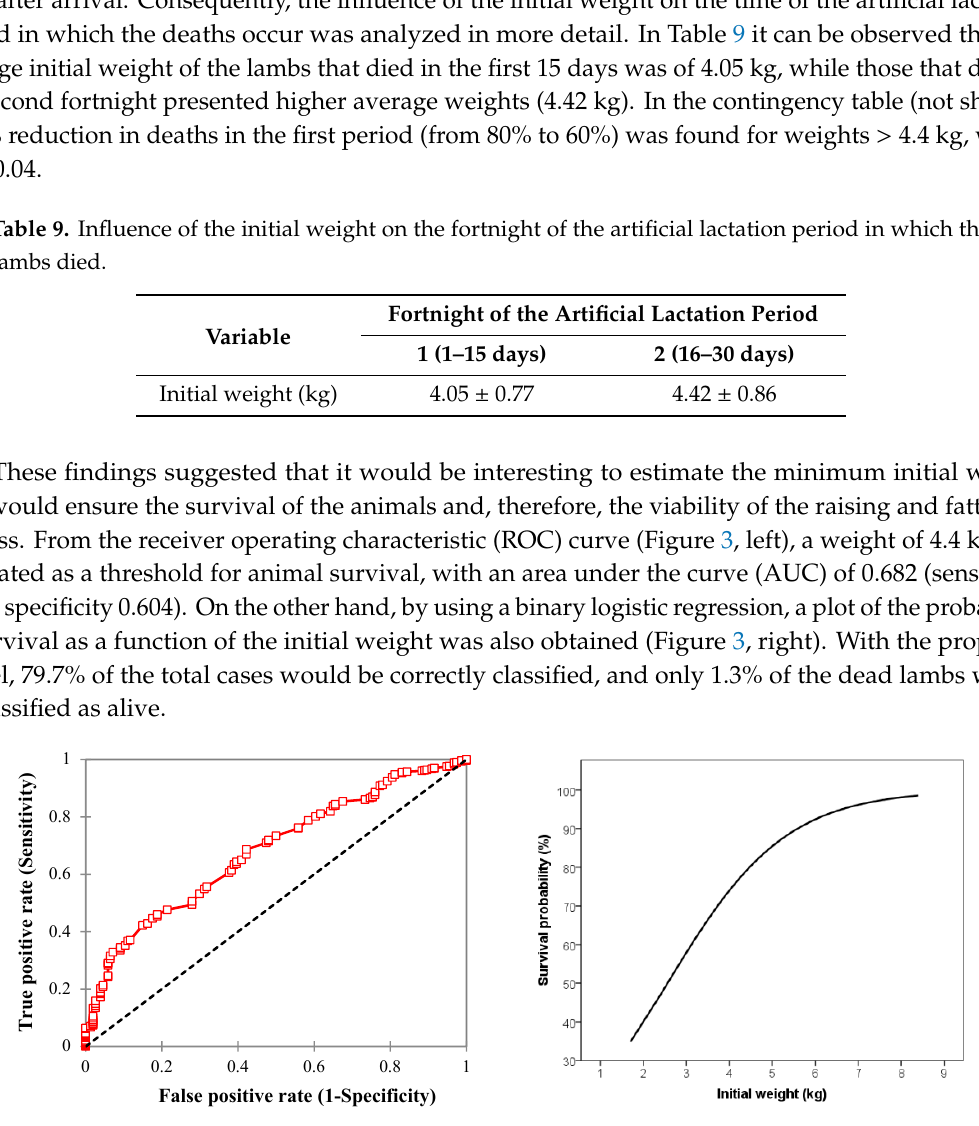
Figure 3. ROC curve ( left ), lamb’s survival probability function as a function of the initial weight ( right ).